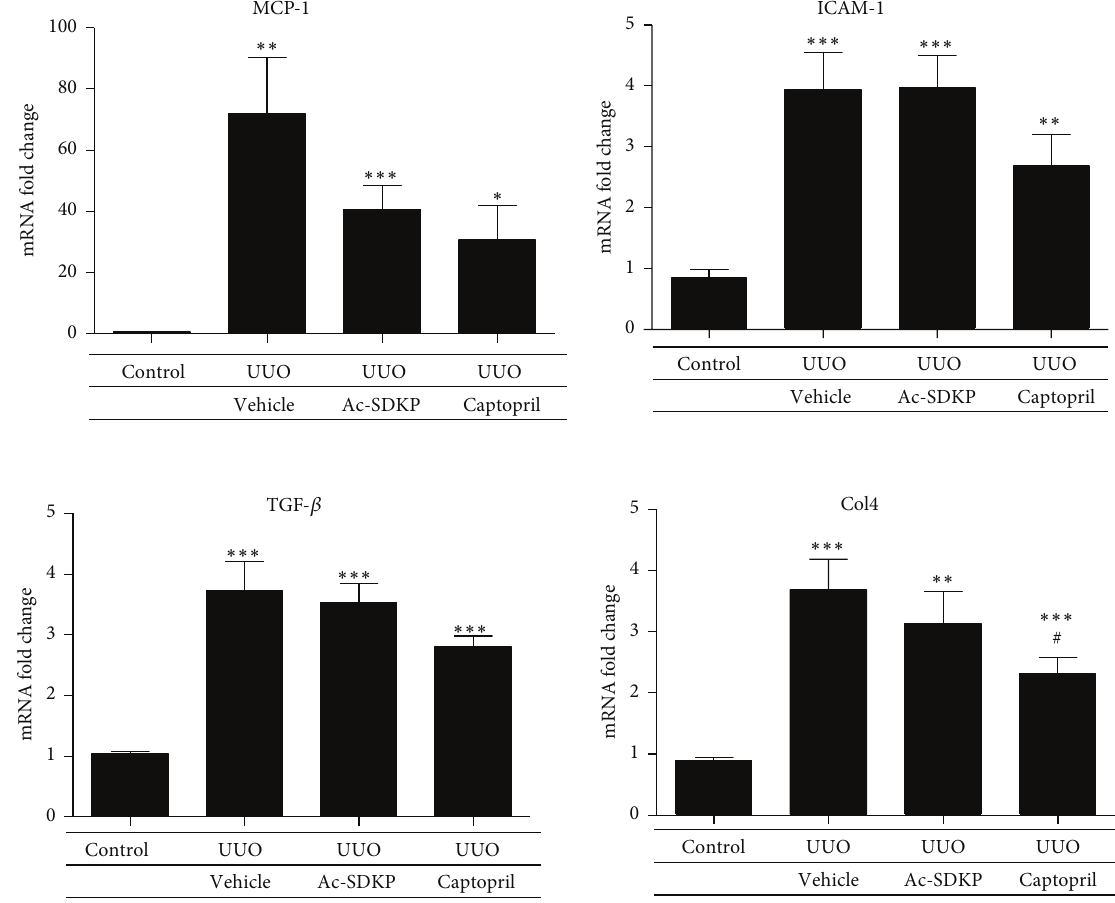
Figure 9: Quantitative analysis of renal cortical mRNA expression of different proinflammatory/profibrotic cytokine genes by real-time PCR in the various experimental